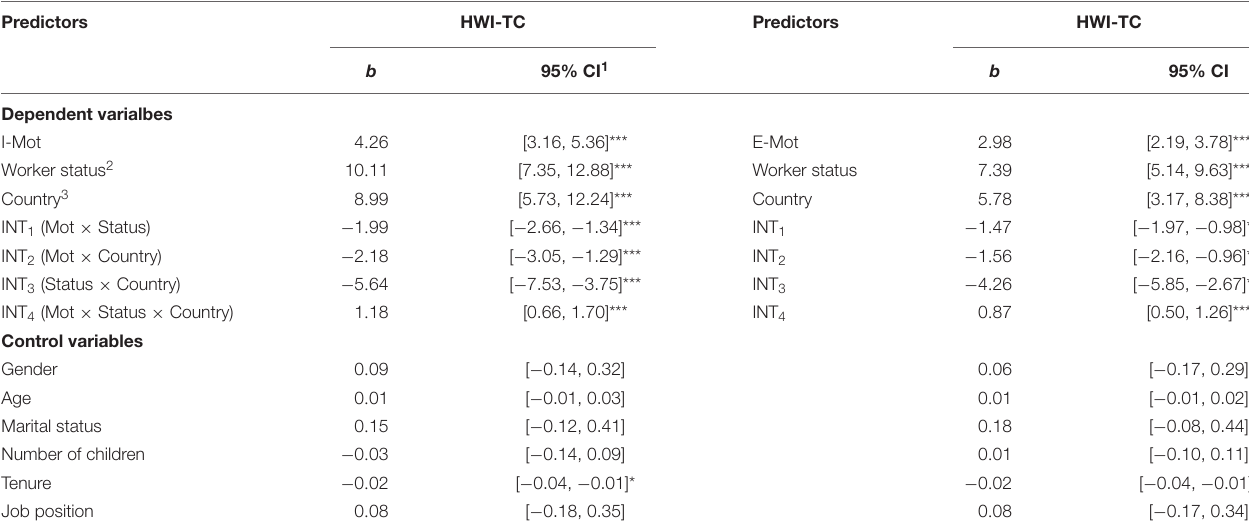
TABLE 4 | Moderficients and confidence intervals (CIs) for predicting HWI-TC. Predictors HWI-TC